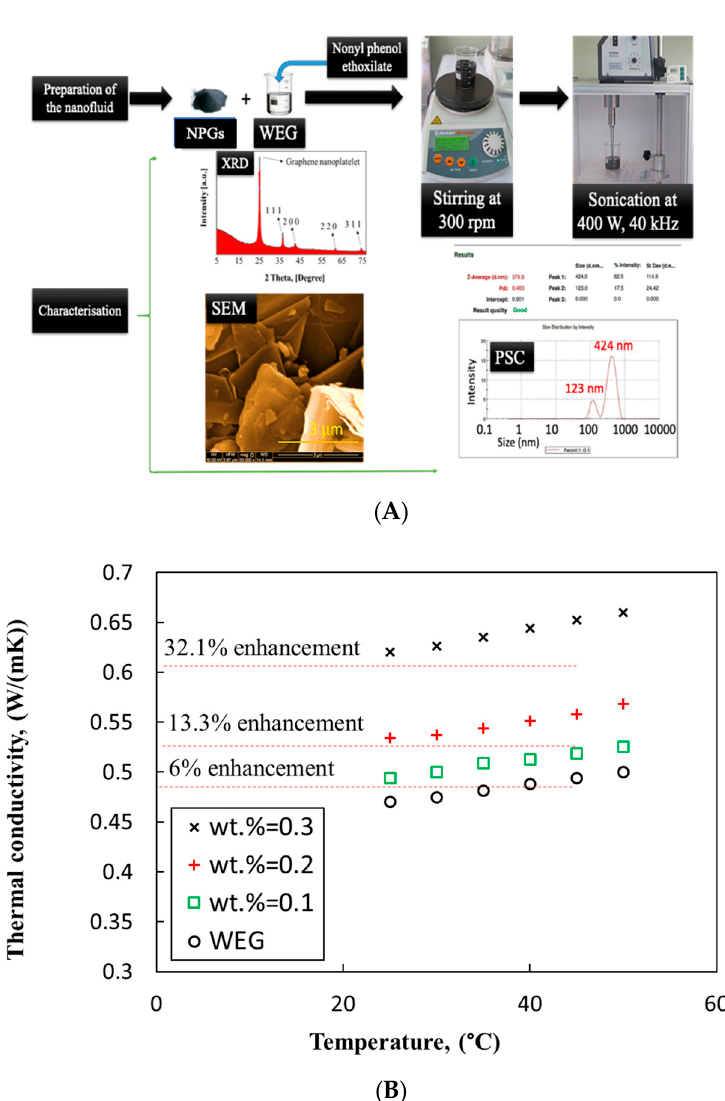
Figure 2. ( A ) Preparation of the nanofluids and the results of the characterisation tests, including X-ray diffraction test (XRD), scanning electron microscopy (SEM), and particle-size test (PSC) conducted on the graphene particles. ( B ) Thermal conductivity of the GNP/WEG nanofluids (the enhancement percentages are the average enhancement for various temperatures at a given mass fraction).